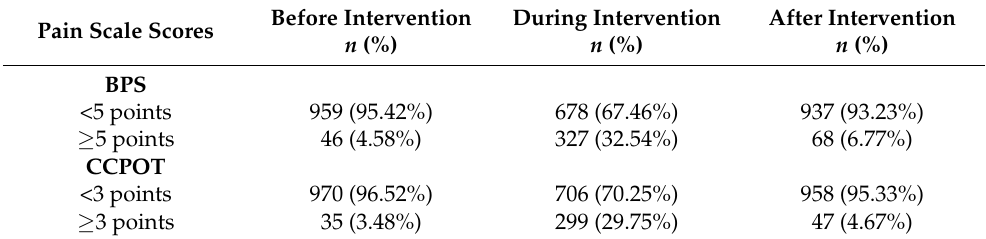
Table 2. BPS and CCPOT score ranges in the study group (data from 1005 measurements).